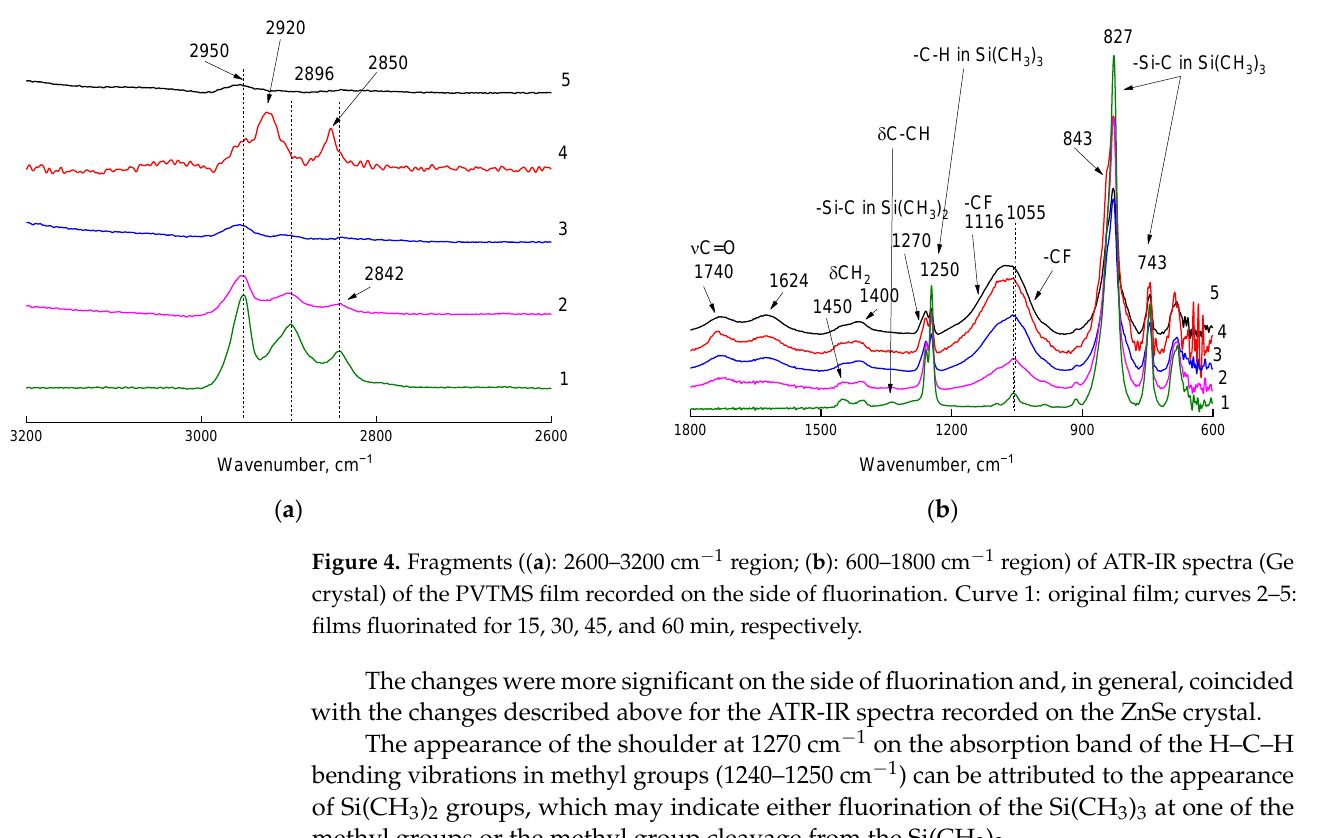
Figure 3. Fragments (( a ): 2600–3200 cm −1 region; ( b ): 600–1800 cm −1 region) of ATR-IR spectra (Ge crystal) of the PVTMS film recorded on the side opposite to the flow of the fluorinating agent. Curve 1: original film; curves 2–5: films fluorinated for 15, 30, 45, and 60 min, respectively.